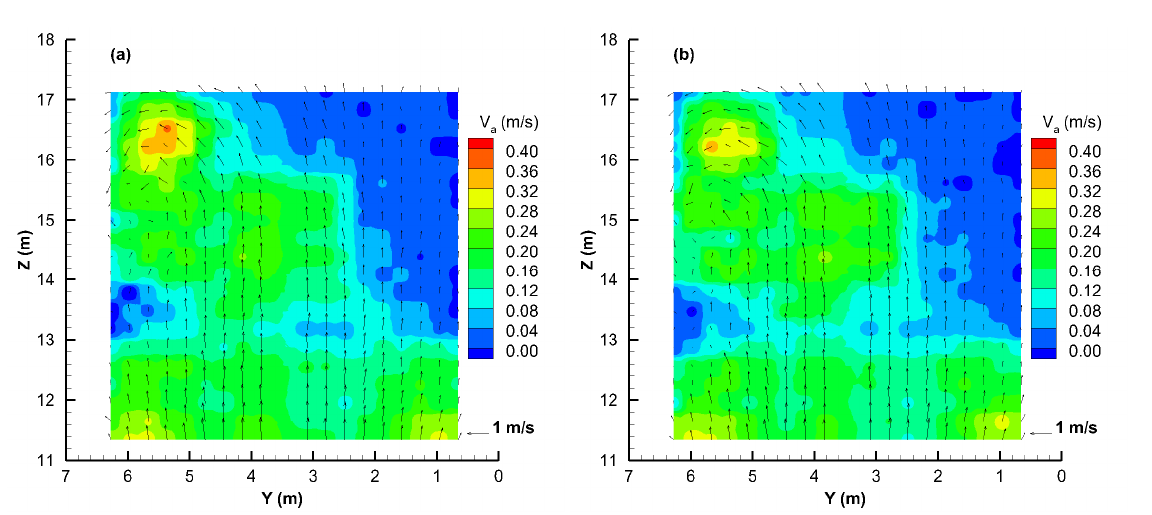
Figure 6. Approach velocity contour at unit 14A, at a turbine unit discharge rate of 340 m 3 /s.